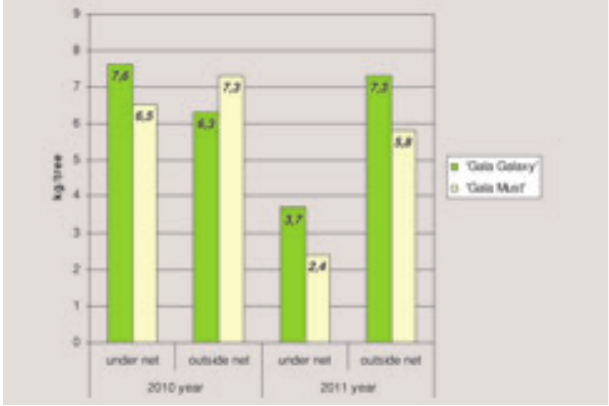
Figure 4. Fruit load of trees under the hail net and outside of it. ( Debrecen- Pallag, 2010–2011)